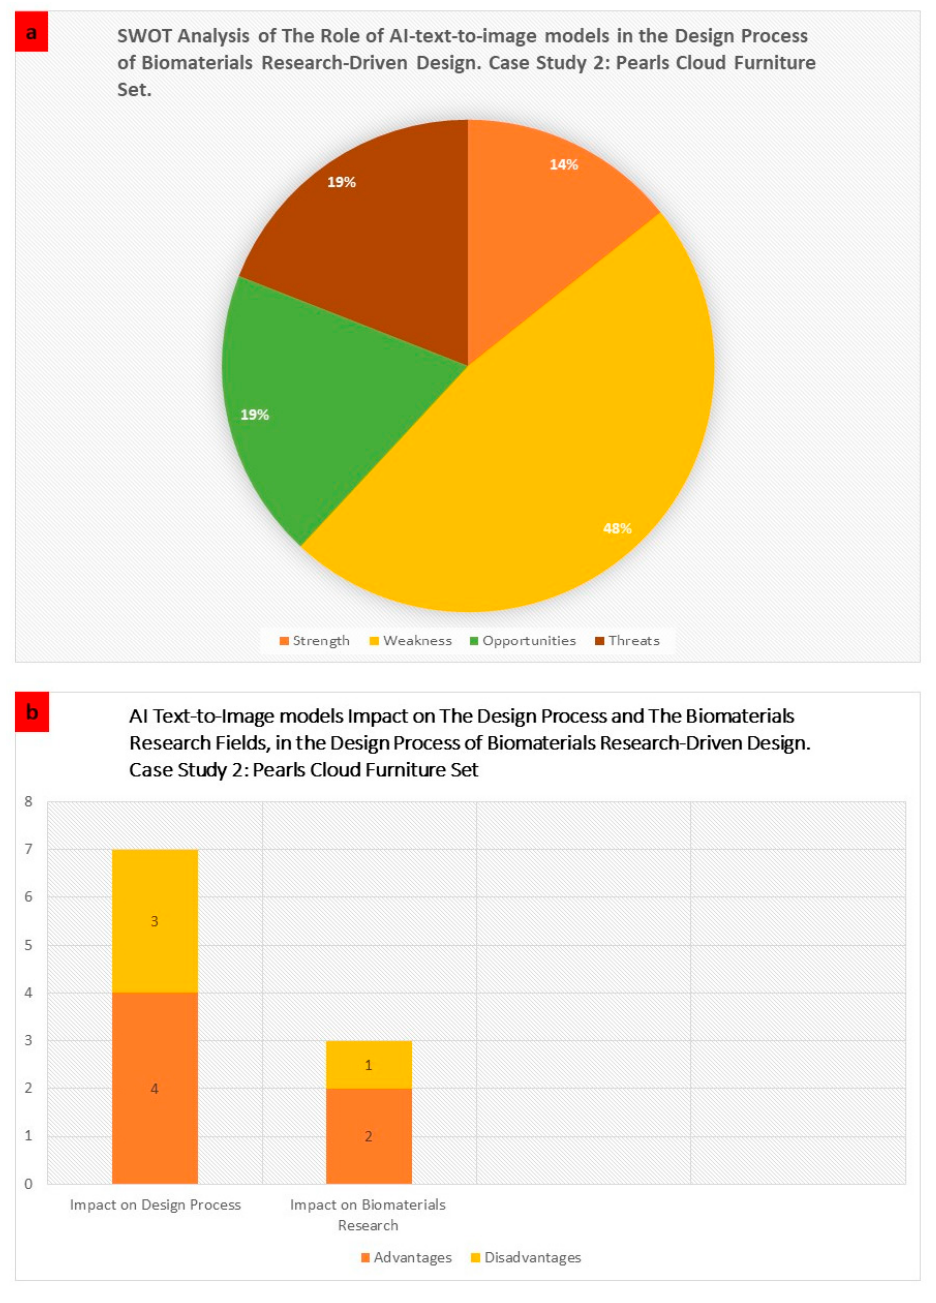
Figure 6. The pearl cloud chair seashell-based biocomposite material from food waste: statistical analysis of the SWOT analysis of the role of AI text-to-image model integration in the biomaterials research-driven design process. ( a ) Statistical estimation of weights of strengths, weaknesses, opportunities, and threats from the SWOT analysis. ( b ) Statistical estimation of the impact of AI text-to-image models on the design process and the biomaterials research fi eld.